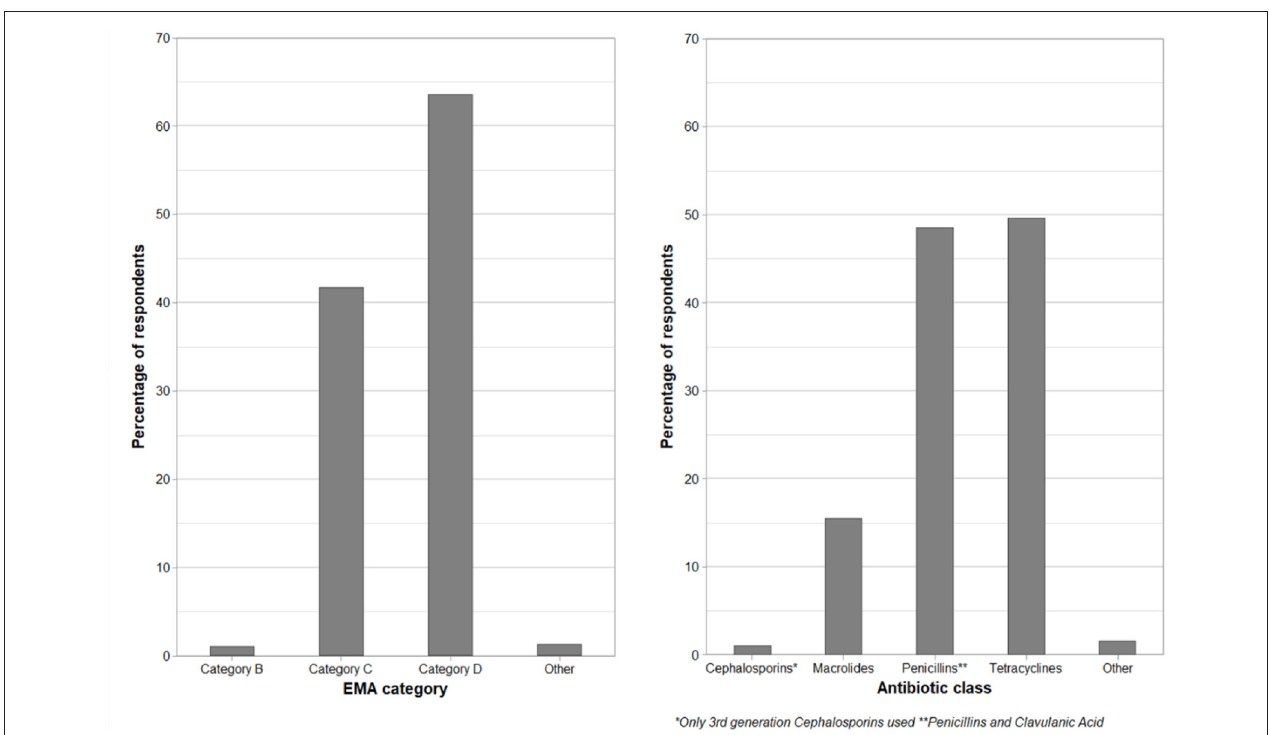
FIGURE 6 | Left-hand panel: Farmer self-reported injectable antibiotics used to treat lame beef cattle, as a percentage of respondents, grouped by the European Medicines Agency categorization ( 25). Right-hand panel: Same data but grouped by antibiotic classification. “Other” includes five unspecified antibiotics, and one farmer used florfenicol. Farmers could state multiple antibiotics. There were 3% (11) of farmers that reported that they do not use an injectable antibiotic (Q8, n = 381).